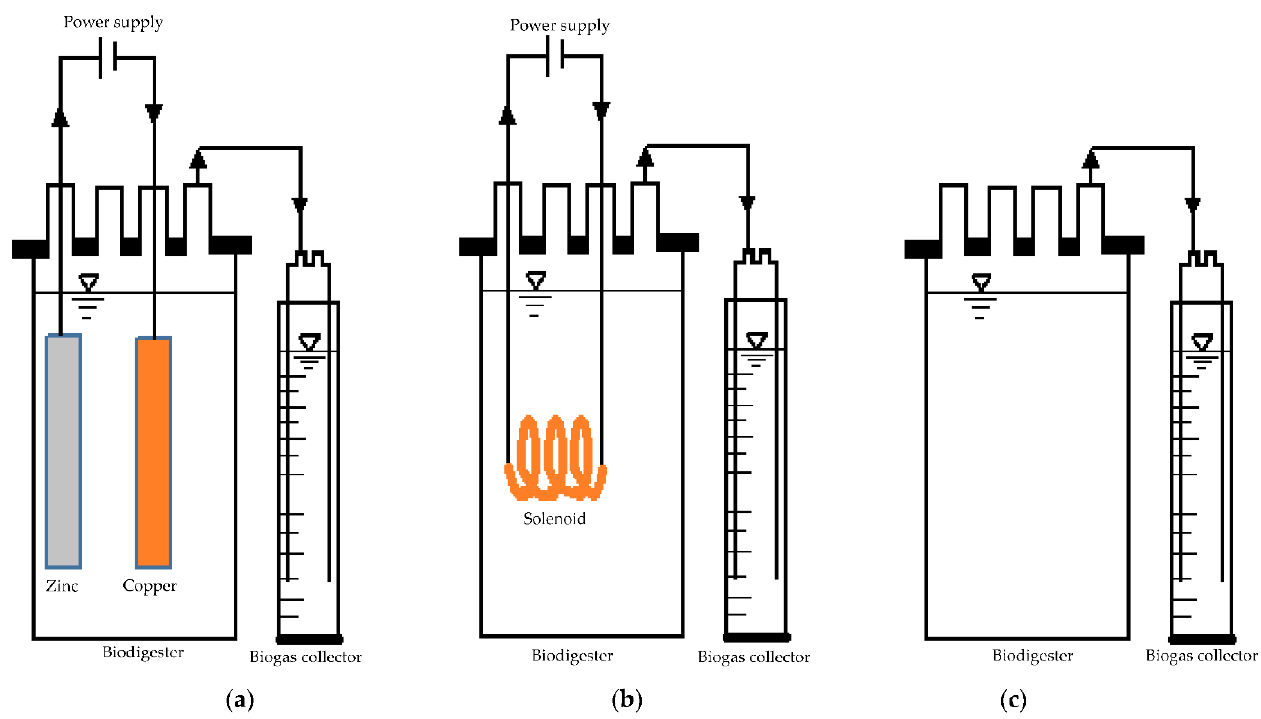
Figure 9. Schematic diagram of ( a ) the microbial electrolysis cell (MEC) with zinc and copper elec- trodes; ( b ) the electromagnetic system (ES) with a solenoid; and ( c ) the control with no power sup- ply.